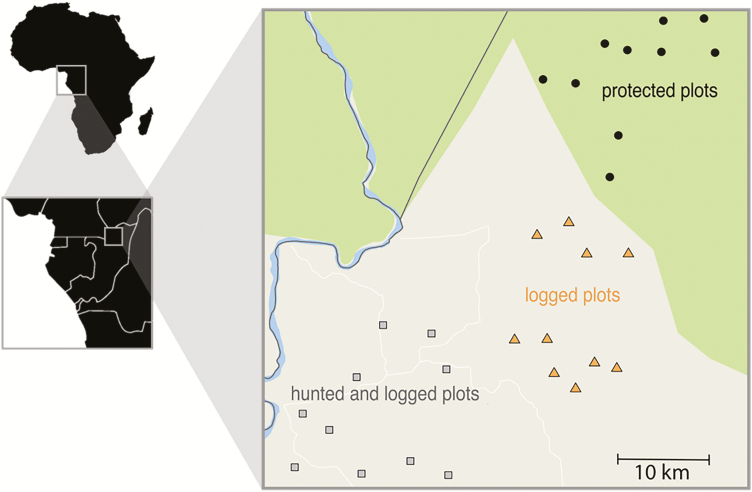
Location of 30 1-ha study plots in Northern Congo. Protected plots fall within the border of Nouabale-Ndoki National Park (green), whereas plots exposed to hunting and/or logging were located in the Kabo logging concession (grey) in northern Republic of Congo.